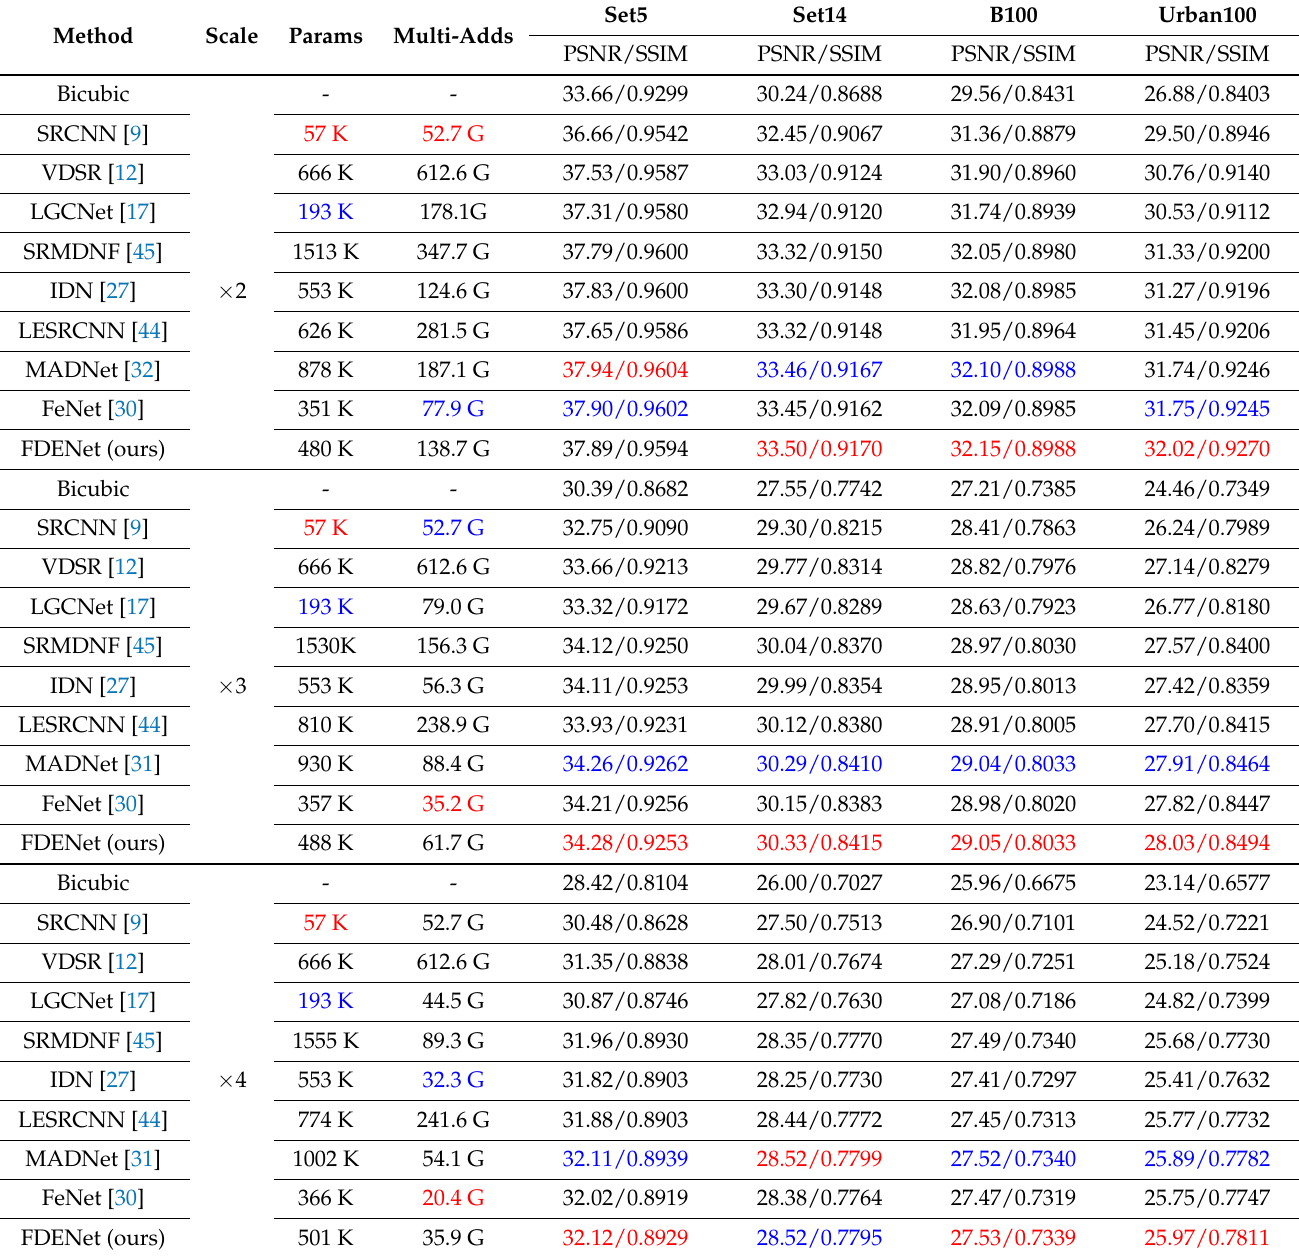
Table 2. Quantitative results of four super-resolution benchmark datasets. “Params” and “Multi- Adds” represent the model’s parameter quantity and model complexity, respectively. The best and second-best results are red and blue, respectively. “-” indicates that no result was